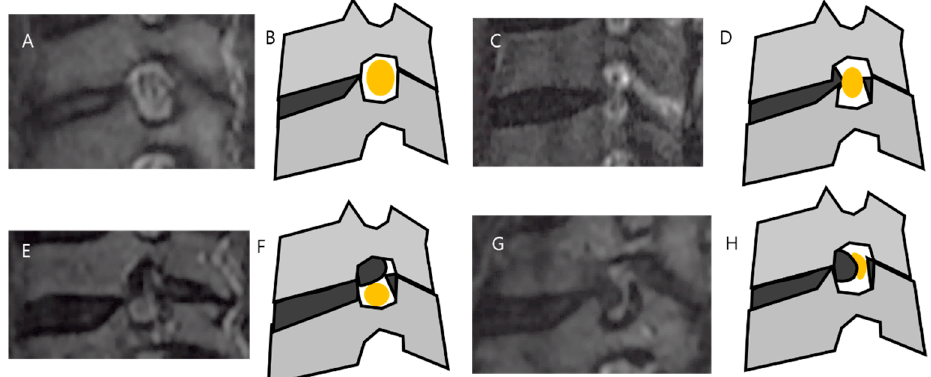
Figure 1. T2 reconstructed oblique sagittal magnetic resonance images and schematic drawing of cervical foraminal stenosis grades 0 ( A , B ), 1 ( C , D ), 2 ( E , F ) and 3 ( G , H ). Grade 0 = no steno- sis; Grade 1 = mild stenosis with perineural fat obliteration < 50% of nerve root circumference; Grade 2 = moderate stenosis with perineural fat obliteration > 50% of nerve root circumference; Grade 3 = severe stenosis collapsed nerve root and morphological changes of the nerve